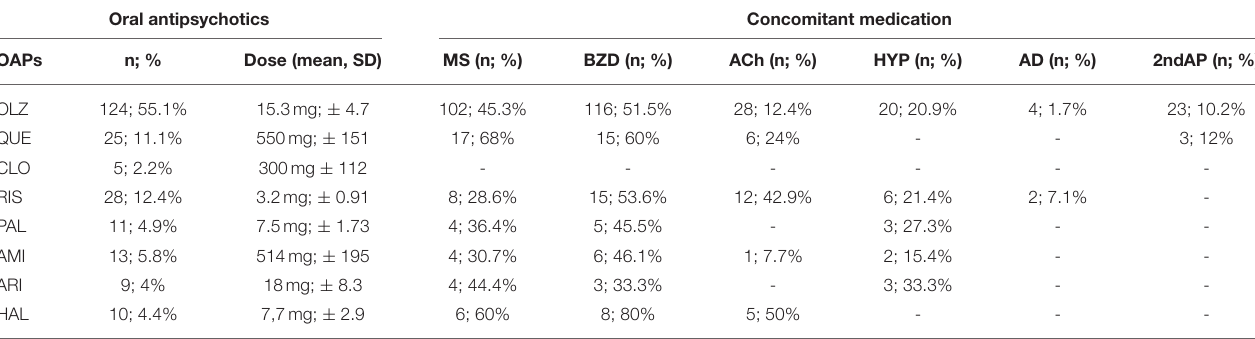
TABLE 4 | Antipsychotic used at discharge.